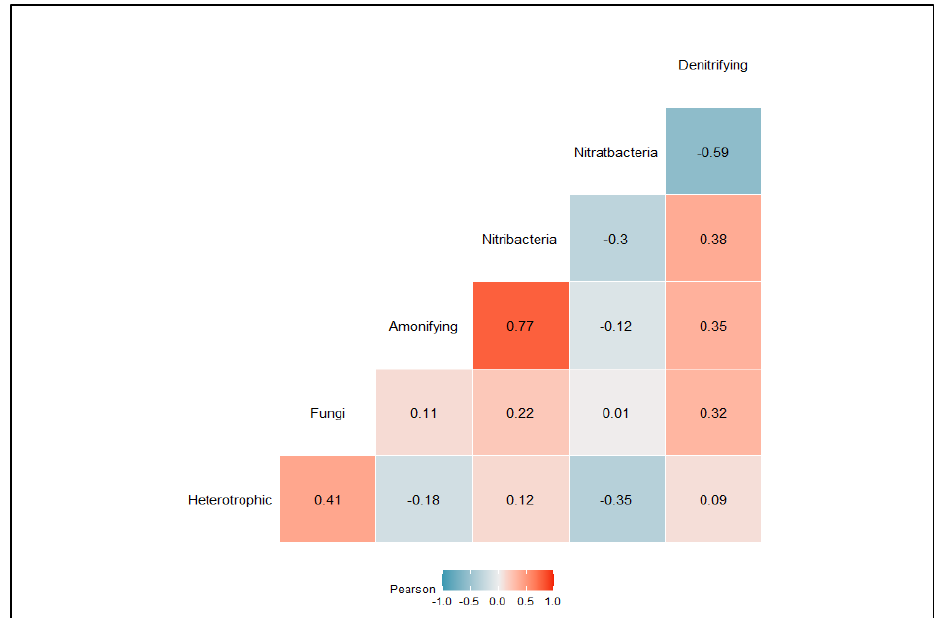
Figure 2. The Pearson correlation computed for the six microbial groups identified in the 12 exper- imental variants.